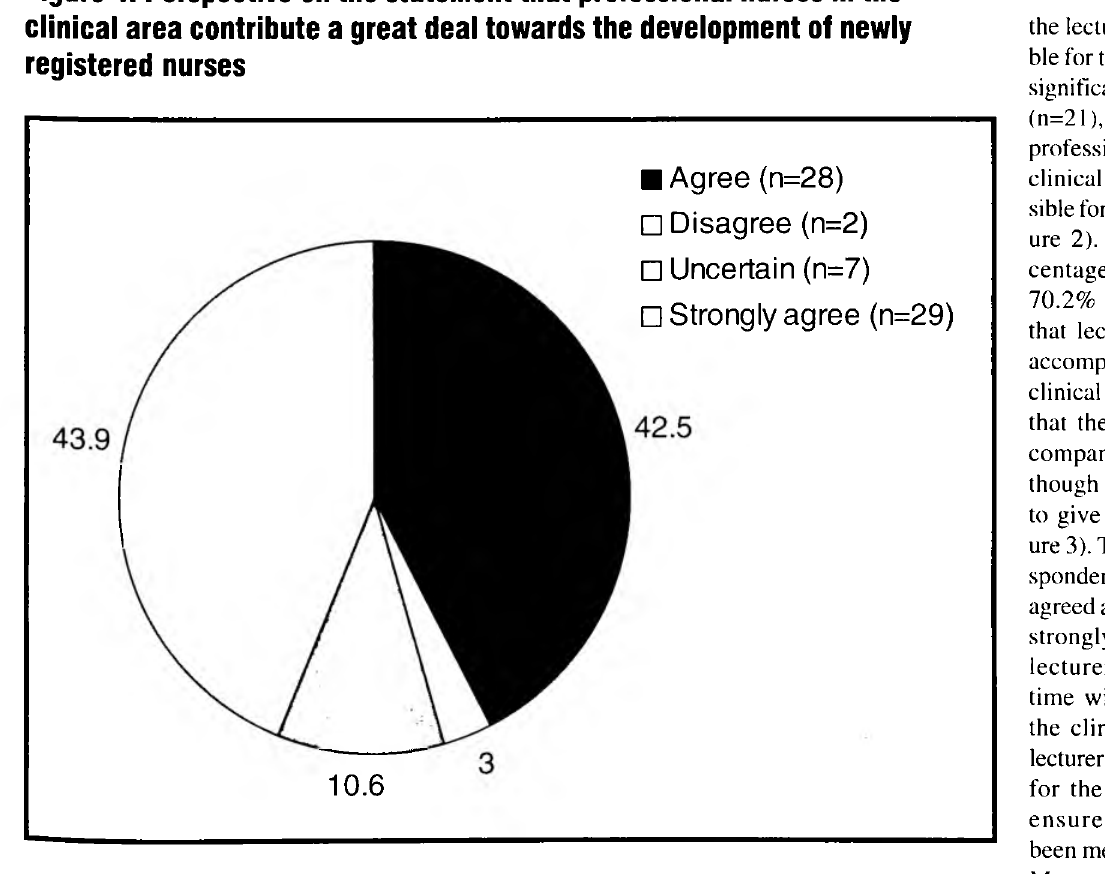
Figure 4: Perspective on the statement that professional nurses in the clinical area contribute a great deal towards the development of newly registered nurses